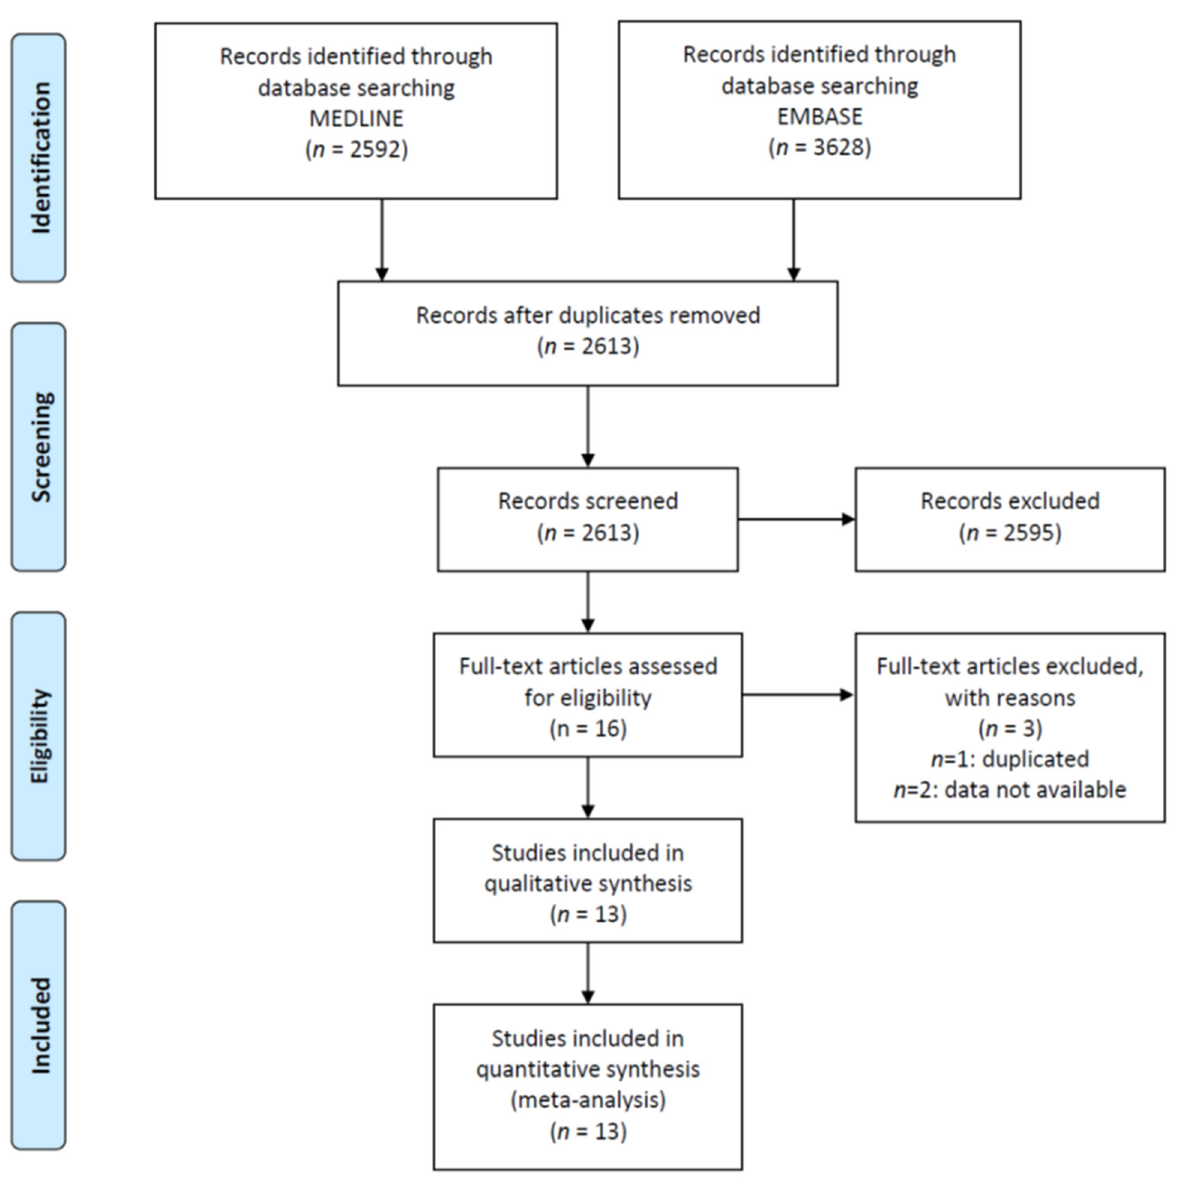
Figure 1. Study Figure 1. Study flow-chart.